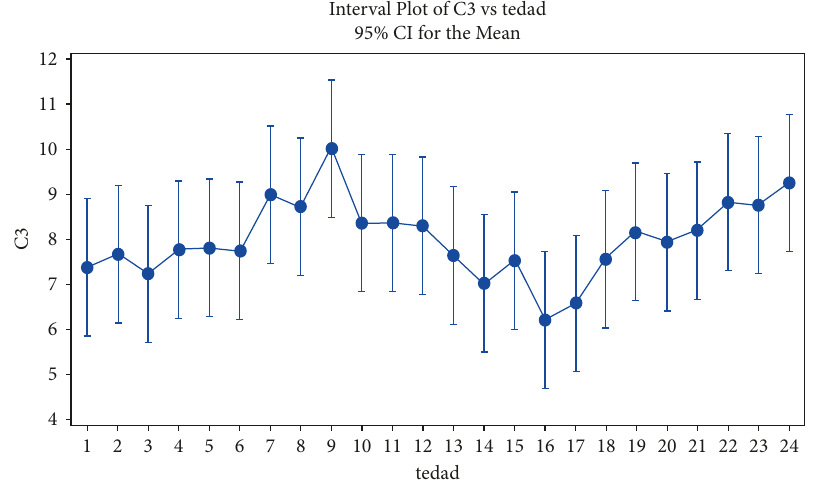
Figure 6: Results of analysis of